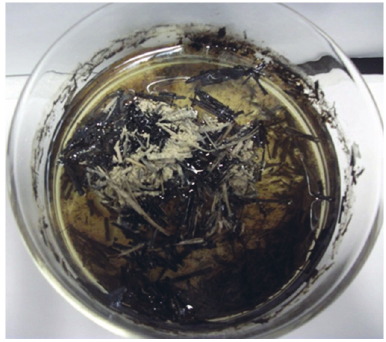
Figure 8. A bitumen sample in Instant Ocean treated with charred hay at room temperature (23 °C) and time = 288 h.